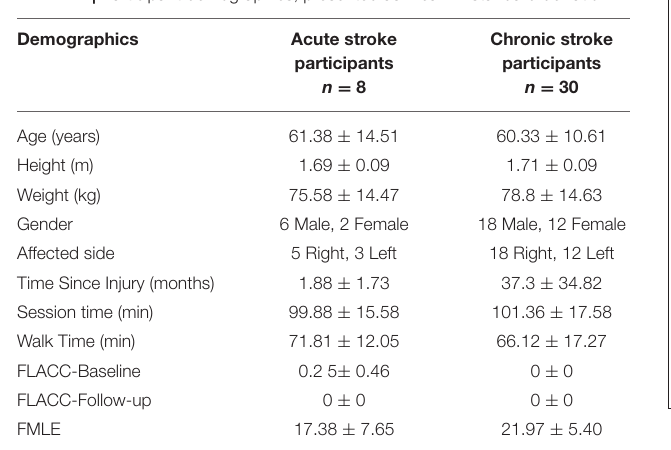
TABLE 1 | Participant demographics, presented as mean ± standard deviation.